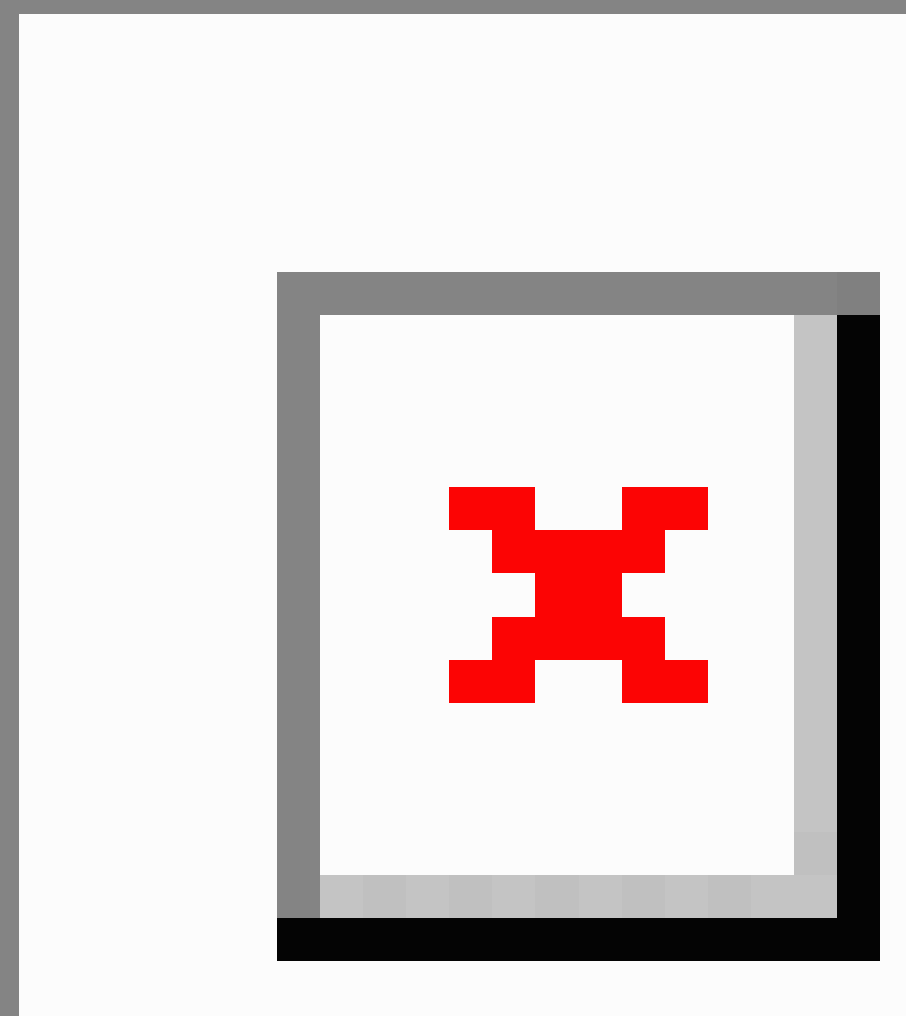
Figure 1. The Xiaomi Mi Band (left) and Microsoft Band (right).